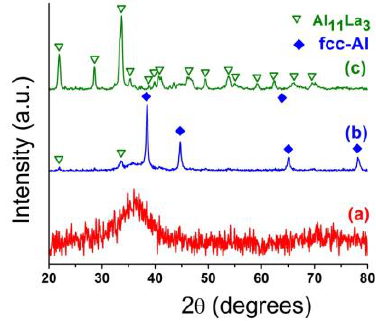
Figure. 4. XRD trace of amorphous Al 82 La 10 Fe 4 Ni 4 MA powder: ( a ) as-milled powder and heat treatment for ( b ) first and ( c ) second crystallization peak temperatures of 682 and 758 K, respectively.